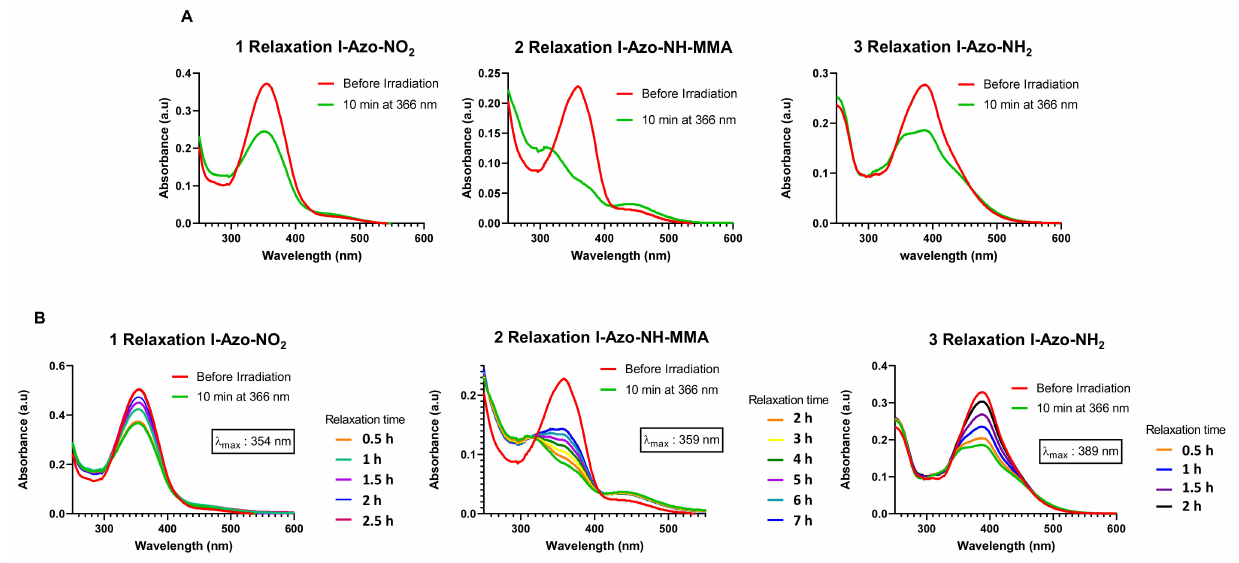
Figure 5. UV-Vis spectra for I–azo–NO 2 ( A1 ), I–azo–NH–MMA ( A2 ) and I–azo–NH 2 ( A3 ) before (red) and after (green) a 10 min exposure to 366 nm light. Thermal relaxation spectra in the dark for I–azo–NO 2 ( B1 ), I–azo–NH–MMA ( B2 ) and I–azo–NH2 ( B3 ).